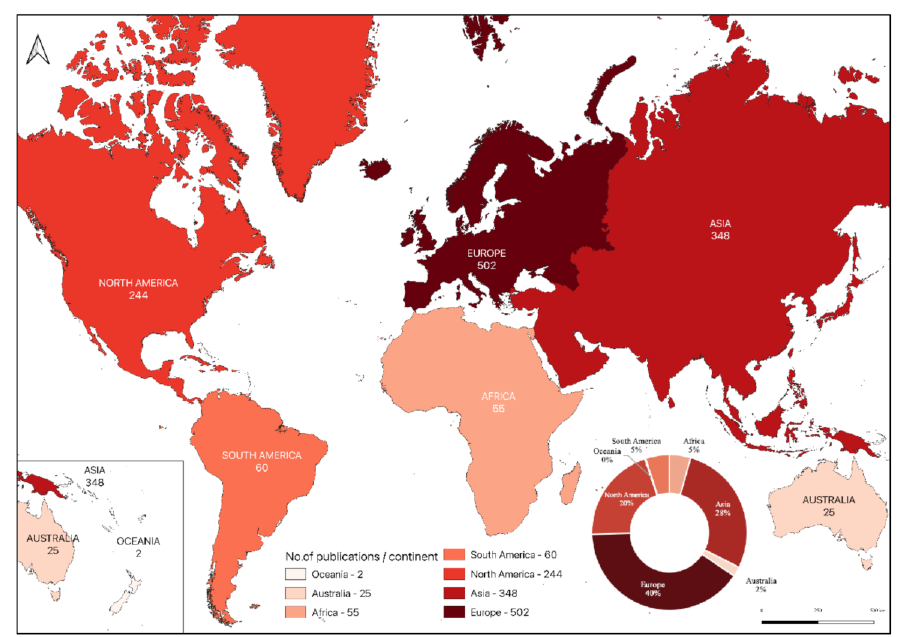
Figure 2. Spatial distribution of research with the number of publications per continent.